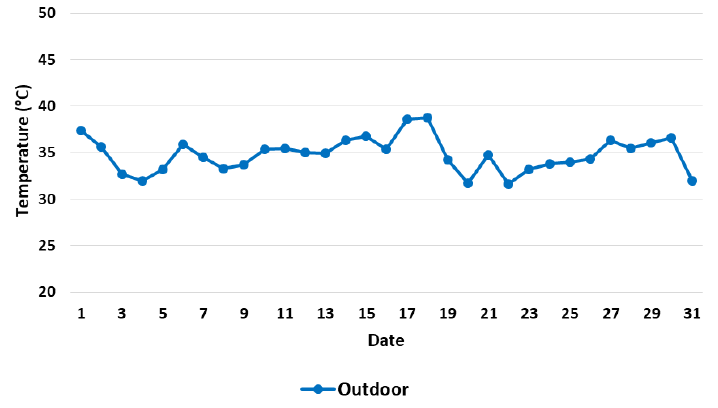
Figure 5. Daily average air temperature of August 2022.